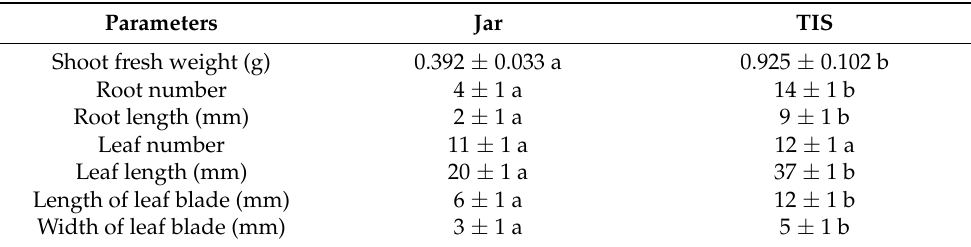
Table 2. Root induction: comparison between the solid (jar) and temporary immersion system (TIS—Plantform) culture systems.